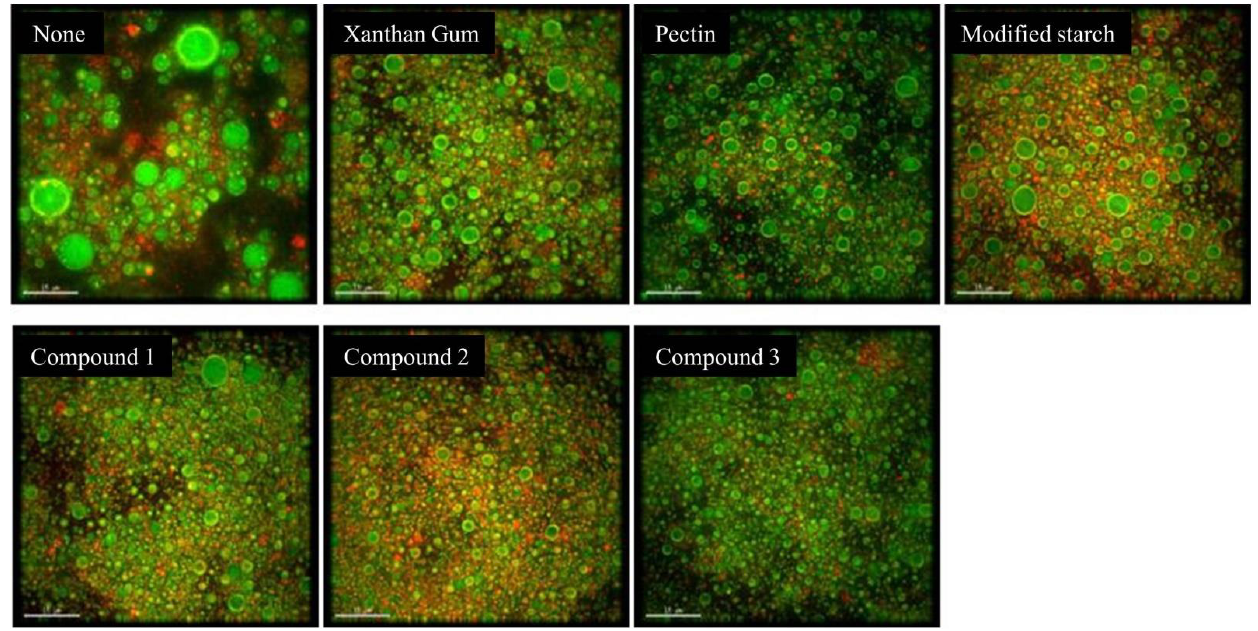
Figure 2. Effects of different stabilizers on the microstructure of SOB-substituted mayonnaise. Com- pound 1 represented xanthan gum, pectin and modified starch in a ratio of 1:1:2, compound 2 represented xanthan gum, pectin and modified starch in a ratio of 2:1:1, and compound 3 represented xanthan gum, pectin and modified starch in a ratio of 1:2:1.